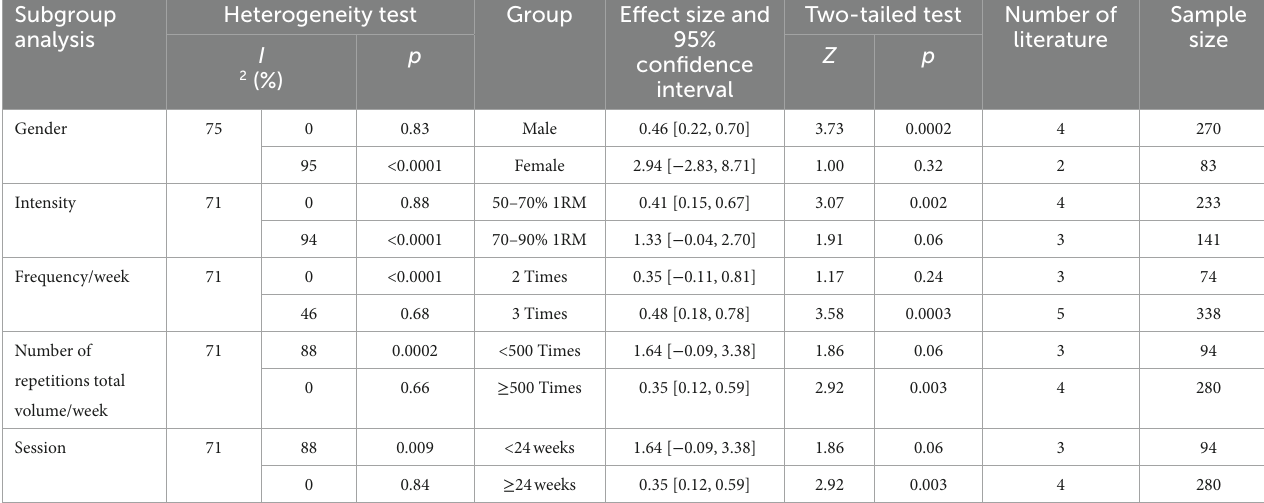
TABLE 2 Results of subgroup analysis on upper limb muscular